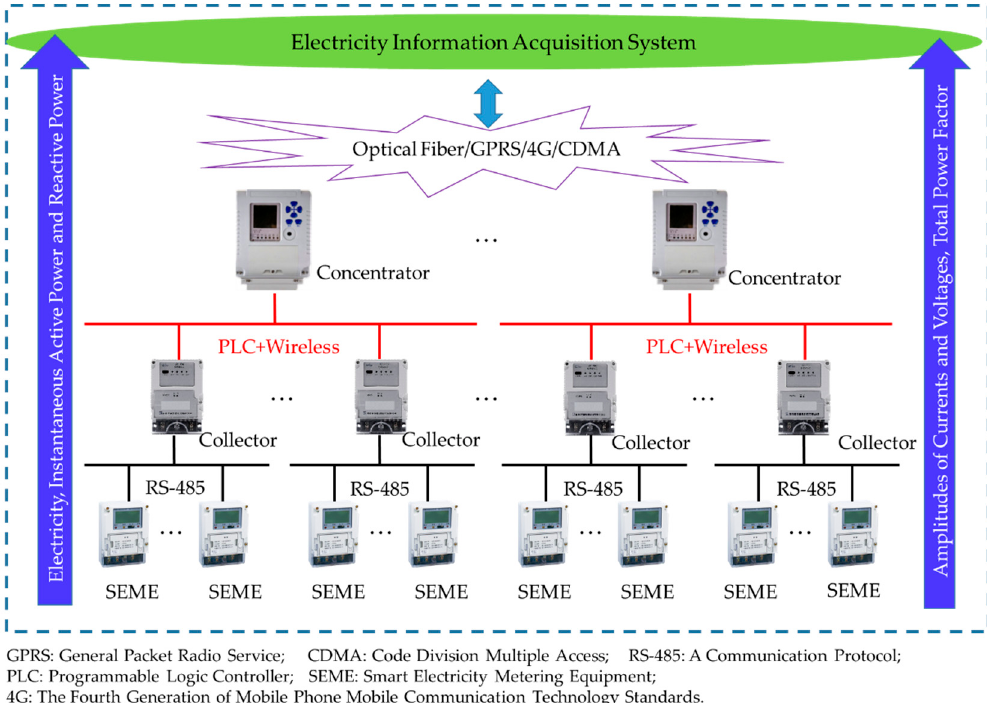
Figure 1. Framework of the electricity information acquisition system.